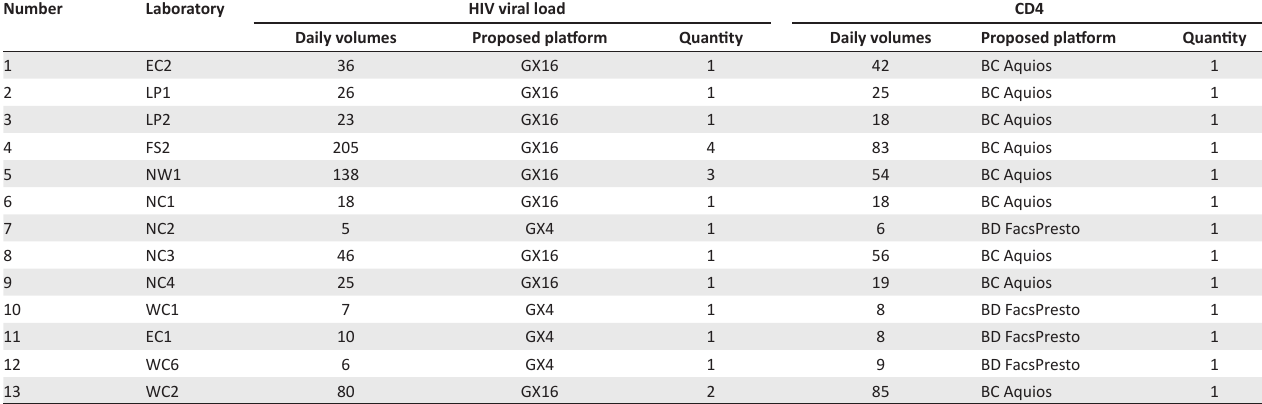
FIGURE 4: Analysis of additional coverage provided by the 13 candidate laboratories that would provide the required diagnostic support for antiretroviral therapy services, South TABLE 3: Daily HIV viral load and CD4 test volumes, capacity required and testing tier for candidate laboratories, South Africa.